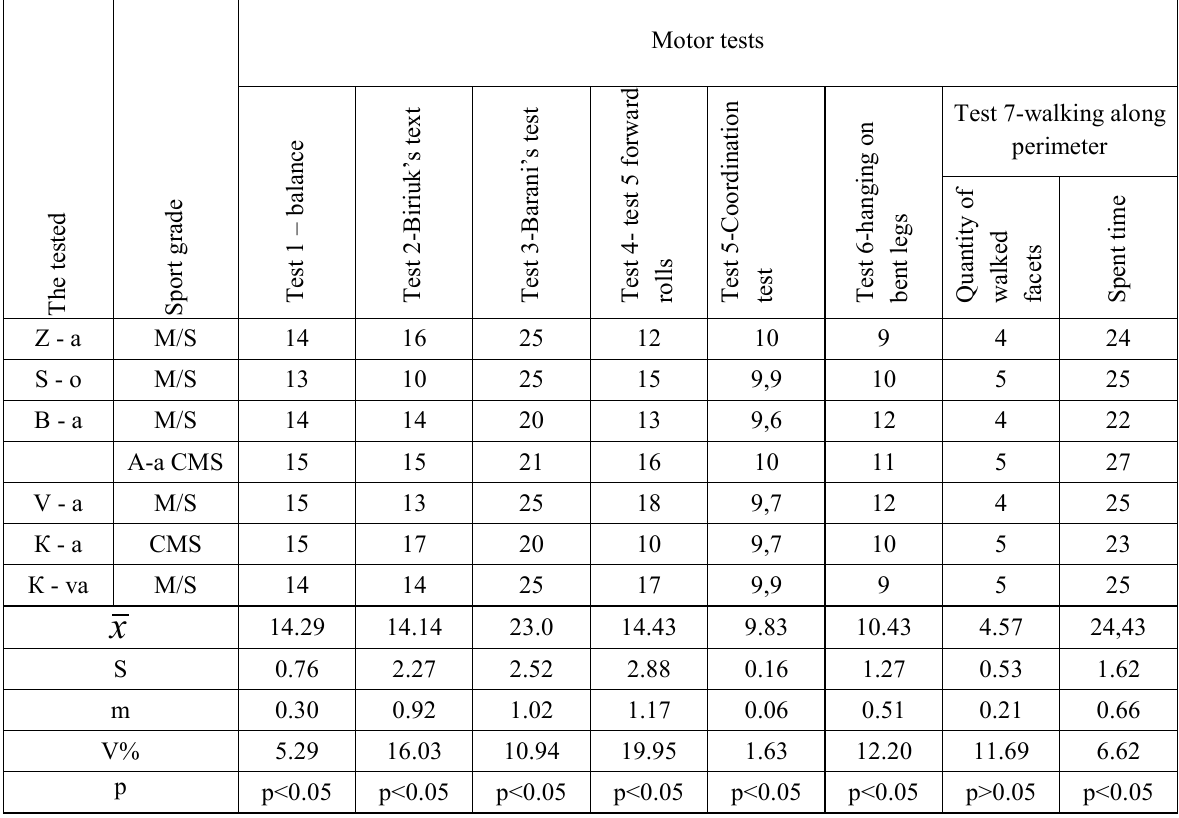
Final indicators of sensor-motor coordination of first year girl students (NUPESU), specializing in sport gymnastic